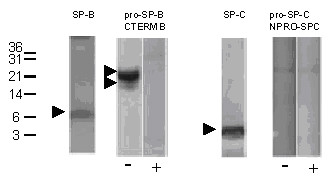
Children with chronic bronchitis. Representative Western blotting pattern of BAL from child with chronic bronchitis (patient control 03). After SDS-PAGE and transfer, the membranes were probed with different antibodies directed against SP-B, certain sequences of the pro-SP-B, in the absences (-) and presence (+) of excess of the peptides, used to raise the antibodies, SP-C and against pro-SP-C, in the absence (-) and presence (+) of excess of the N-terminal peptide, used to raise these antibodies. The numbers next to the lanes indicate the molecular weight in kDa. The arrow heads indicate bands of interest, as described in the text. All bands were analyzed under reducing conditions.